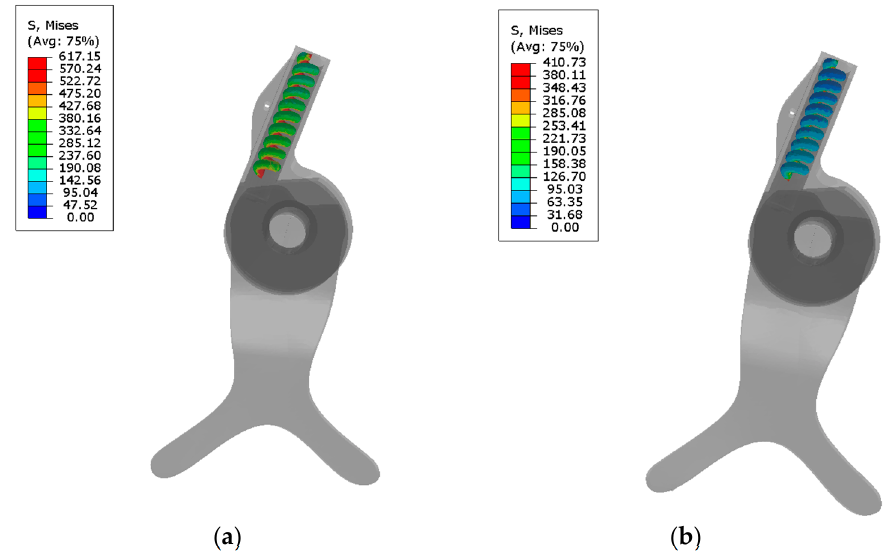
Figure 19. Von Mises stress distribution at the maximum plantar flexion: ( a ) Stainless Steel, ( b ) NiTi spring. (Unit = MPa).